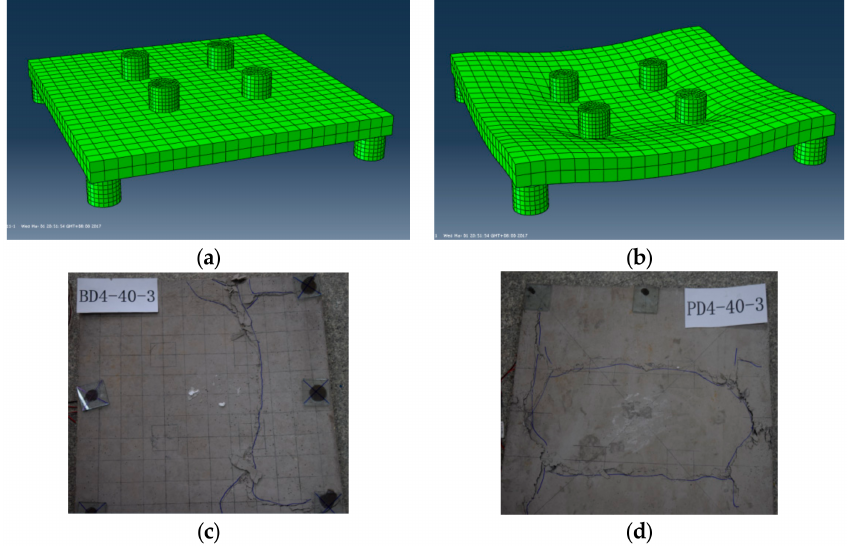
Figure 20. Simulated deformation and failure modes of specimens. ( a ) Simulated deformation before loading; ( b ) Simulated deformation after loading; ( c ) Failure mode of specimen BD4-40-3; ( d ) Failure mode of specimen